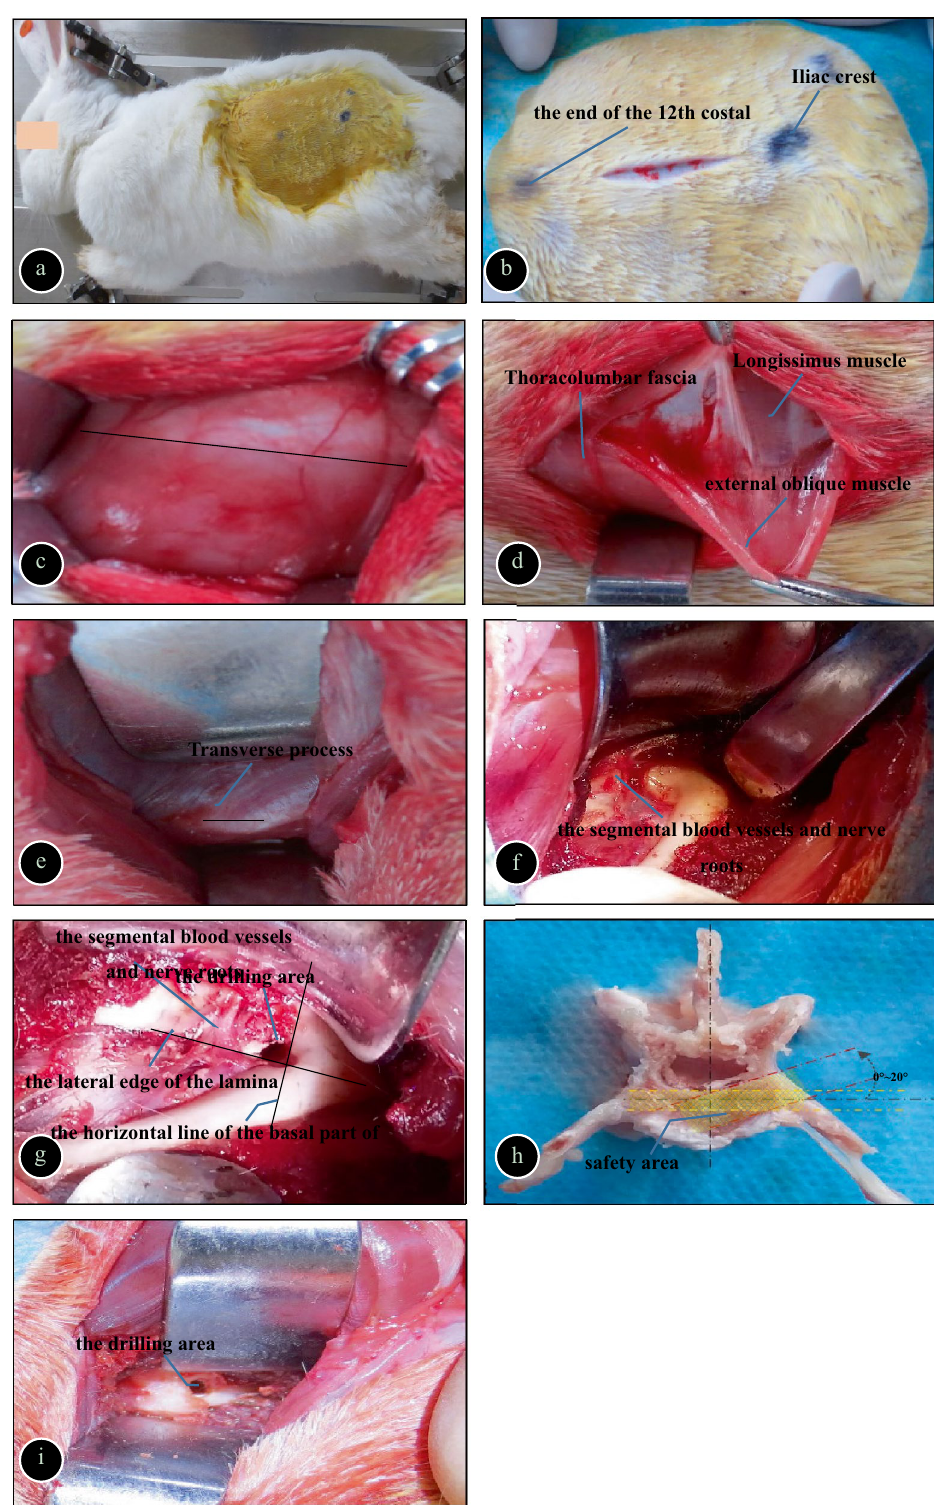
Figure 1. ( a ) Surgical position; ( b ) Surgical incision; ( c ) The thoracolumbar fascia was cut along the dotted line (red and white); ( d ) The intramuscular space between the longissimus and obliques was dissected bluntly; ( e ) The apex of the transverse process was exposed; ( f ) The vertebral body and the lateral side of the intervertebral disc were exposed, and segmental blood vessels and exiting nerve roots could be seen; ( g ) The drilling site of the posterolateral approach; ( h ) The drilling angle and safety zone of the posterolateral approach; ( i ) The drilling site of the ventral transverse process